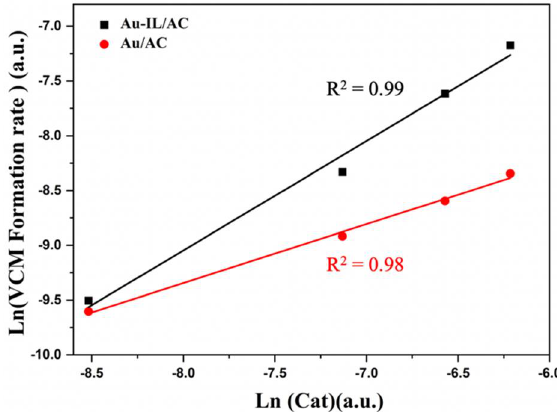
Figure 3. Changes in the natural logarithm of the VCM formation rate with the natural logarithm of the catalyst concentration. The SDs for the black and red data are 1.01 and 0.54, respectively.